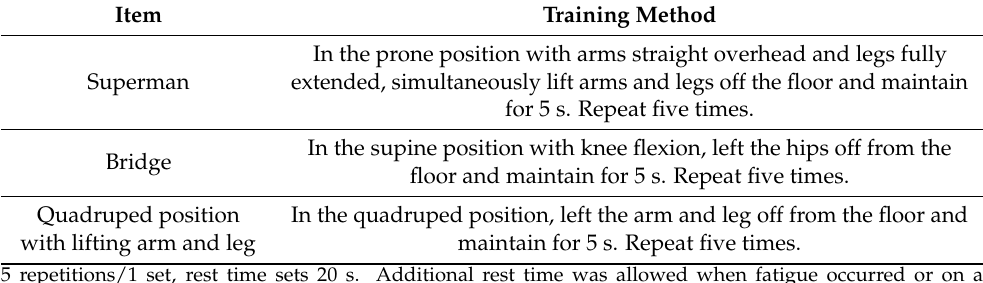
Table 2. Cont. Item Training Method In the prone position with arms straight overhead and legs fully Superman extended, simultaneously lift arms and legs off the floor and maintain for 5 s. Repeat five times. In the supine position with knee flexion, left the hips off from the Bridge floor and maintain for 5 s. Repeat five times. Quadruped position In the quadruped position, left the arm and leg off from the floor and with lifting arm and leg maintain for 5 s. Repeat five